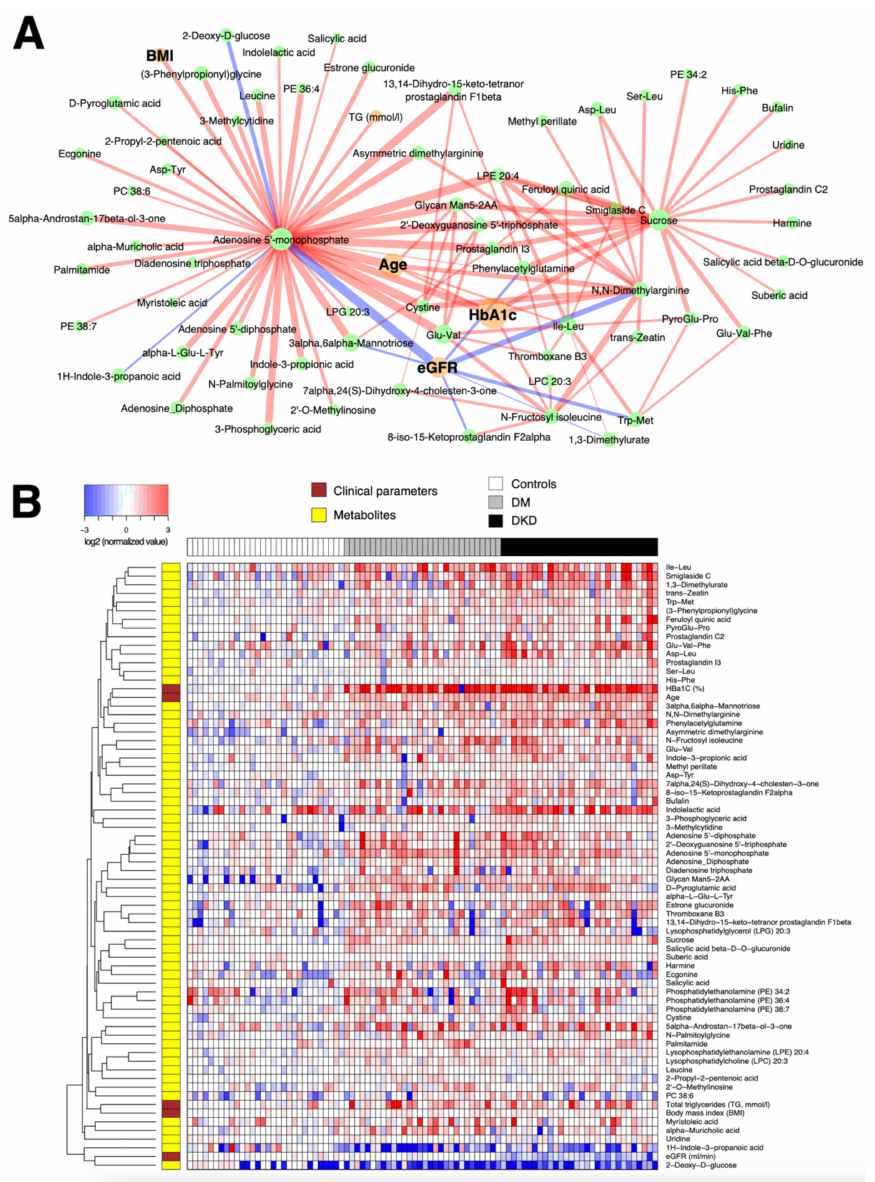
Figure 3. ( A ) Subnetwork signature of 60 DM patients compared to the 30 controls. Network edges are drawn in different colors depending on the sign of the partial correlations (positive in red, negative in blue); thicker edges represent stronger relationships. The size of the nodes corresponds to their respective –log10(q-value) from univariate differential abundance tests (two-sample t-test). ( B ) To demonstrate the abundance patterns more clearly, heatmap of relative abundance values of individual compounds was drawn (log-transformed, base 2) normalized by the median of the control